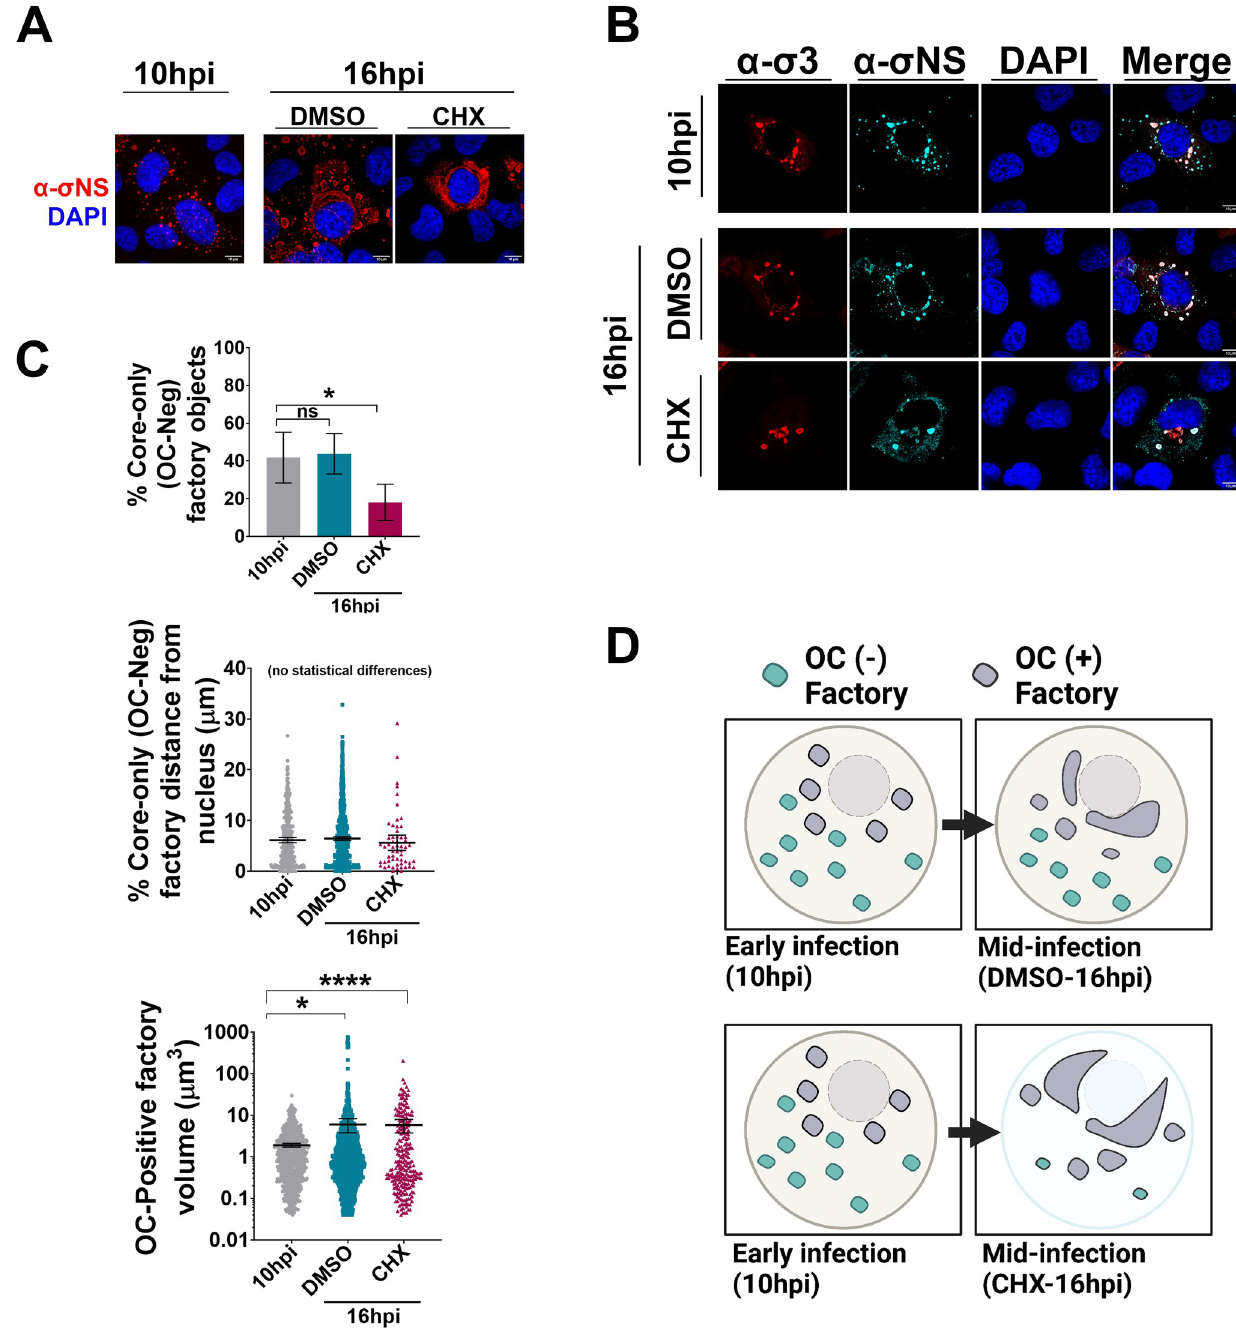
Fig 8. Peripheral viral factories are diminished and diffuse if translation is inhibited during early infection. (A, B) Representative images of H1299 cells were infected with reovirus at an MOI of 3, and at 10 hours post infection (hpi) cells were either fixed (A) or treated with 100 μ g/mL cycloheximide or DMSO (B) . (A) Cells were immunofluorescently labelled with monoclonal mouse α - σ NS (3E10 directly conjugated to AlexaFluor 568 or 2A9 directly conjugated to AlexaFluor 647, red) in combination with DAPI for nuclei staining (blue). (B) At 16hpi, cells were fixed and immunofluorescently labelled with monoclonal mouse α - σ 3 (10G10, AlexaFluor 647, red), monoclonal mouse α - σ NS (3E10 directly conjugated to AlexaFluor 568, or 2A9 directly conjugated to AlexaFluor 647, cyan) and DAPI for nuclei staining (blue). All images were acquired via immunofluorescence spinning disk confocal microscopy. (C) The total number of factory objects, their volumes, and the edge-to-edge distances from the nucleus were quantified across a minimum of ten cells for each condition. ( C, Top) the percentage of σ NS factory objects lacking σ 3 staining were plotted. (C, middle) The edge-to-edge distance of σ NS factory objects lacking σ 3. (C, bottom) The volume of σ NS factory objects containing σ 3. All graphs are plotted as mean +/- 95% CI. Statistical analysis is reported as multiple unpaired t-test between 10hpi and DMSO or CHX. ���� p < 0.0001, ��� p < 0.001, �� p < 0.05, ns > 0.05. (D) Cartoon schematic summarizing the changes in factory distribution upon cycloheximide treatment at 10hpi. Figure created in